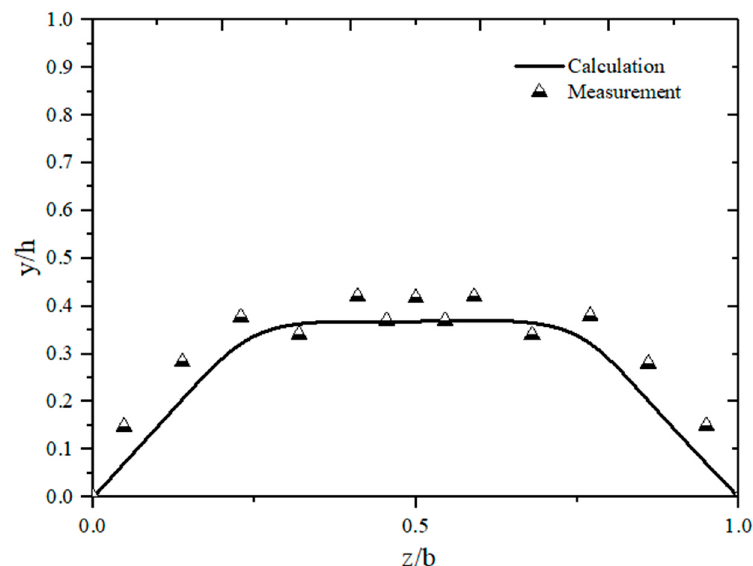
Figure 7. Comparison of the location of depth average velocity between the calculated and measured values along different vertical lines from the bedform to the water surface ( b / h = 4.615).